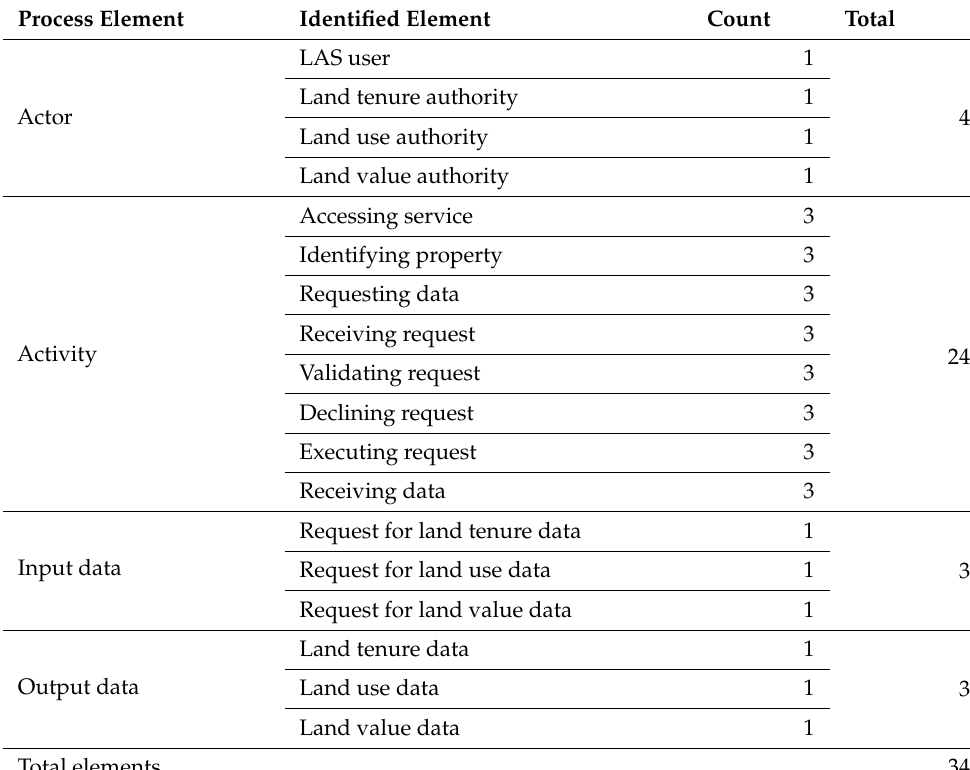
Table 2. Elements identified in the current process model. Source: Own